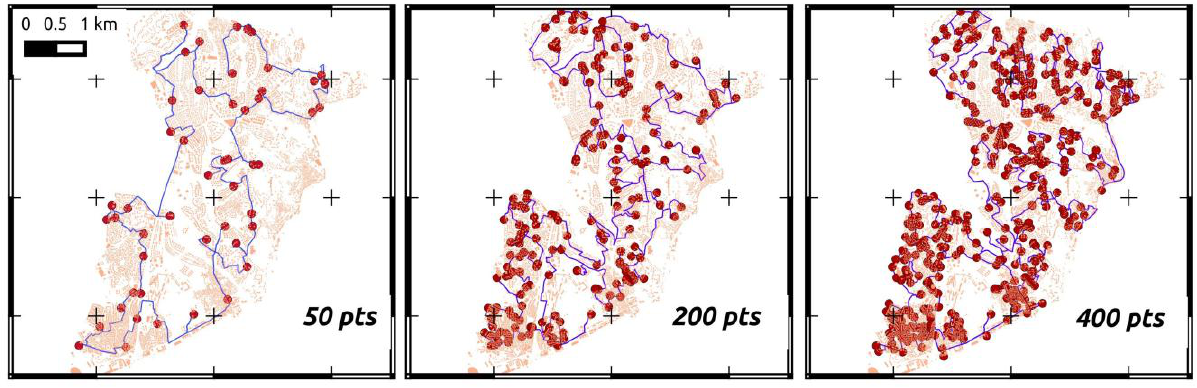
Figure 14. Comparison among different single stage surveys based on different sample sets. From the left, results are shown for 50-, 200-, and 400-point sample